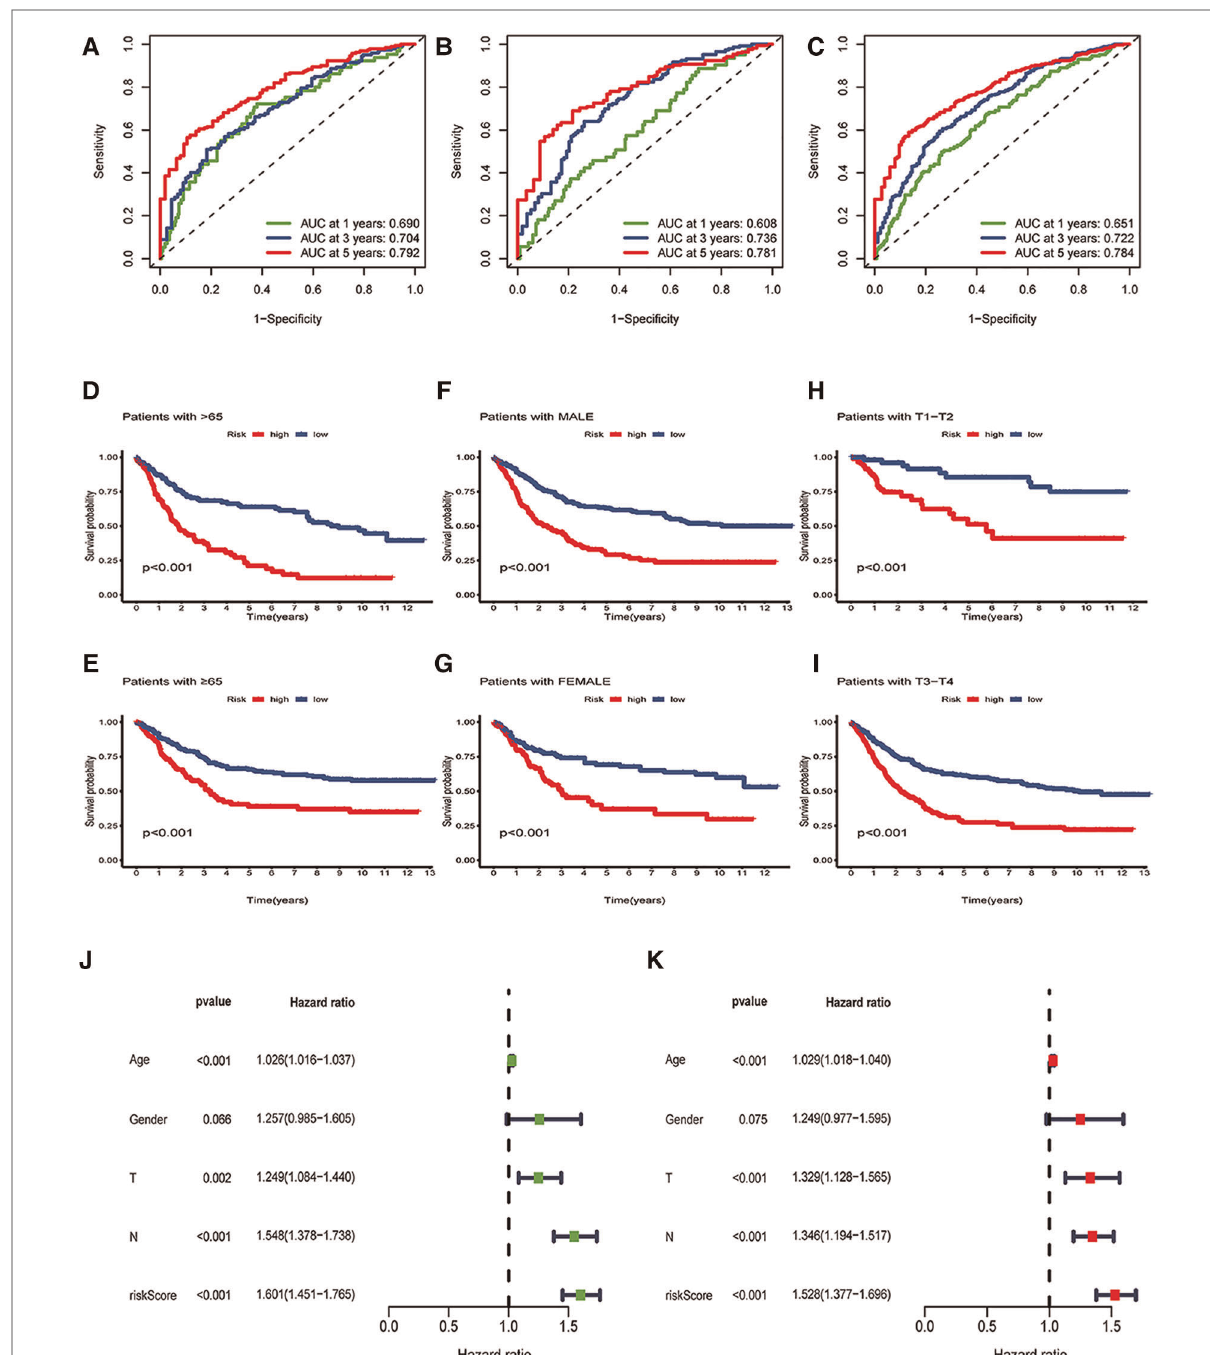
FIGURE 5 Independence analysis and hierarchical analysis of OE_score. ( A ) Using ROC curve to predict the sensitivity and speci fi city of 1-, 3-and 5-year survival rates based on OE_score in the training set. ( B ) Using the ROC curve, the sensitivity and speci fi city of predicting 1-, 3-and 5-year survival rates based on OE_score in the test set. ( C ) Using the ROC curve, the sensitivity and speci fi city of OE_score in predicting 1-, 3-and 5-year survival rates in the total data set. ( D – I ) Survival analysis of OE_score in high and low age groups, different gender groups and early and late T stage groups. ROC, receiver operating characteristic. ( J ) Univariate Cox regression analysis was used to determine that OE_score could be used as an independent factor affecting the prognosis of patients with gastric canser. ( K ) Multivariate Cox regression analysis was used to determine that OE_score could be used as an independent factor affecting the prognosis of patients with gastric